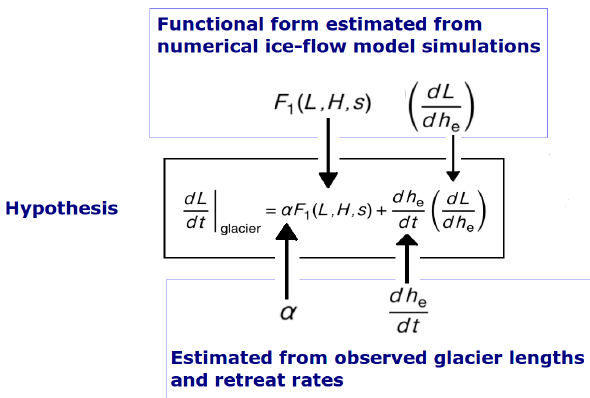
Fig. 5. Schematic view of modelling